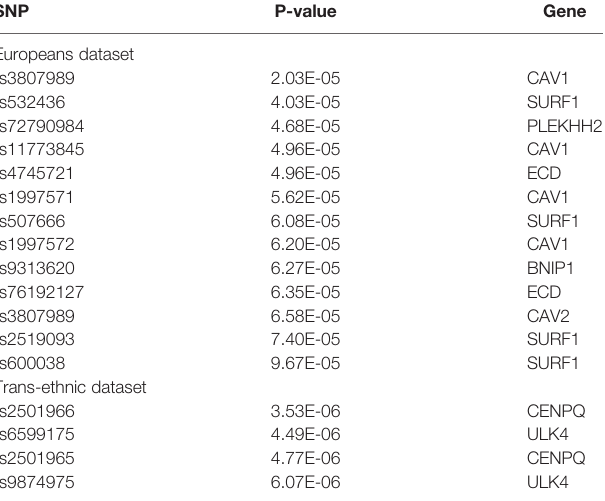
TABLE 4 | SMR results of small vessel stroke. SNP P-value